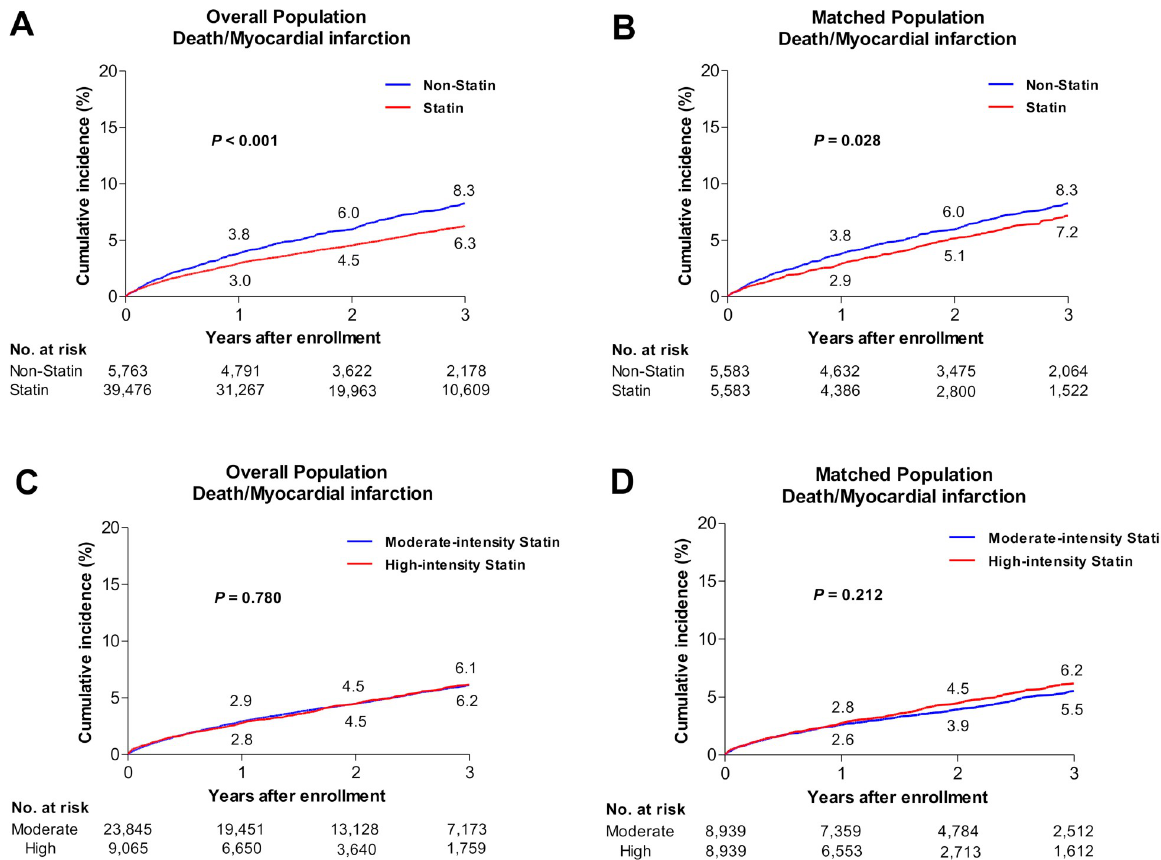
Fig 2. Cumulative incidence rates for clinical outcomes in the study population. Cumulative incidence rates for all-cause death/myocardial infarction in overall (A) and matched (B) population between the statin and non-statin therapy groups; all-cause death/myocardial infarction in overall (C) and matched (D) population between the high- and moderate-intensity statin therapy groups. The numbers in each figure represent the cumulative incidence rates at each time points.